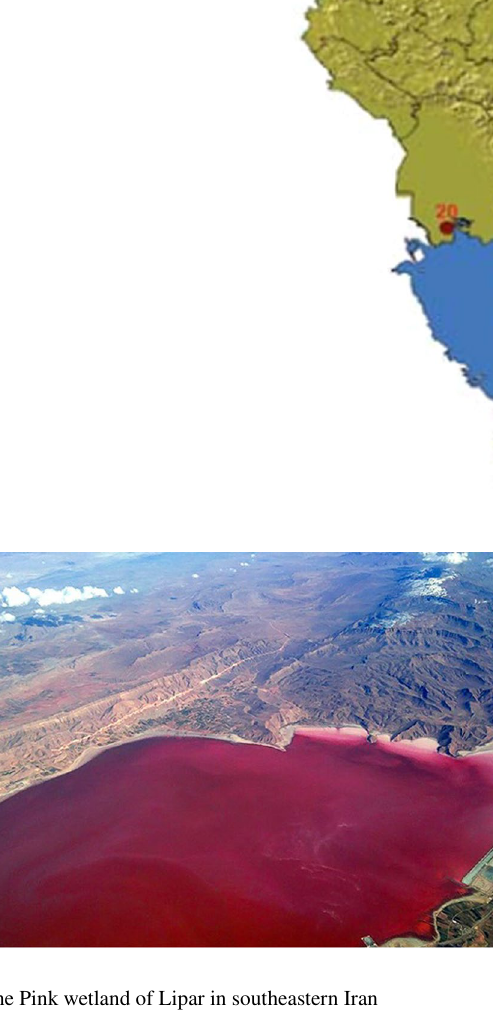
Fig. 3 Sarandoon, Balandoon Wetland Complex in Sari,